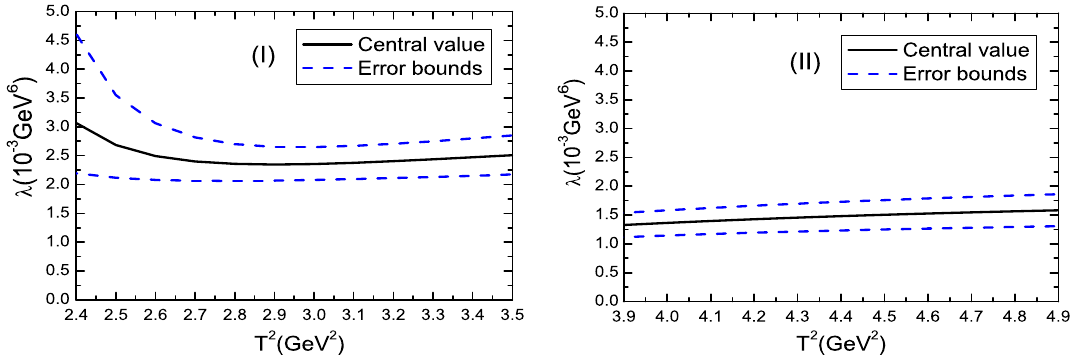
Fig. 3 The pole residues of the triply-charmed pentaquark states with variations of the Borel parameters, where the (I) and (II) denote the negative parity and positive parity pentaquark states, respectively